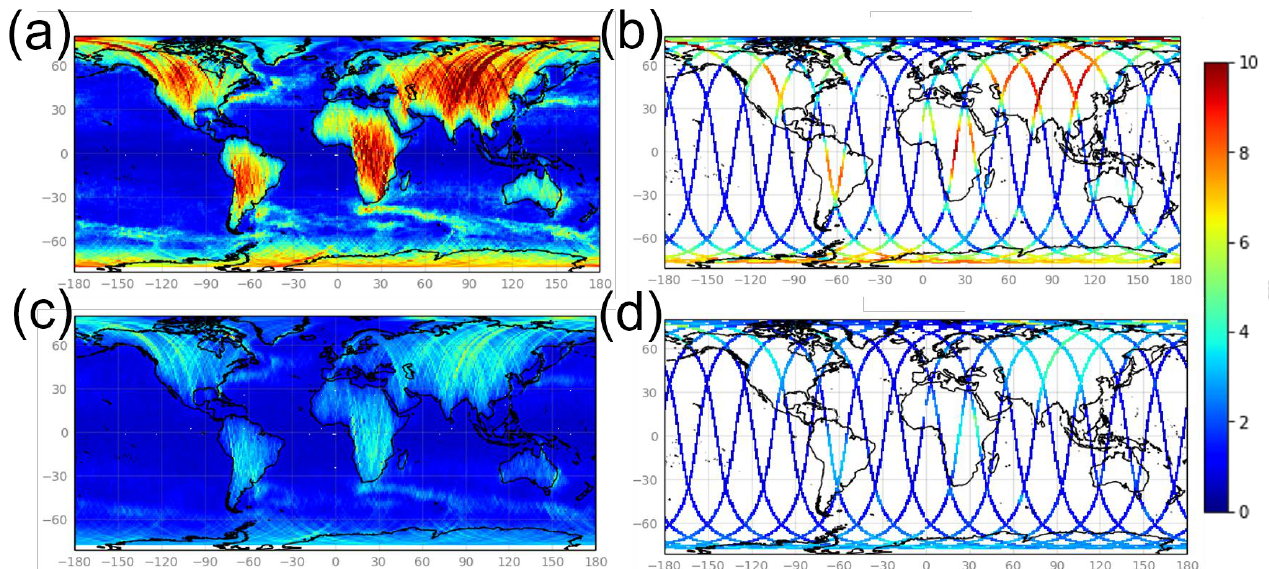
Figure 18. Residual systematic errors after the Level-3 data-driven calibration is applied (unit: cm RMS). The left panels are for SWOT’s 21-day orbit. The right panels are for the one-day orbit. The upper panels are for the “Spectral Allocation” uncalibrated scenario and the lower panels are for the “Current Best Estimate 2021” scenario. Table 3. Overview of the global Level-3 performance after data-driven calibration for different sce- narios. The left columns are for the global ocean (sea-ice regions are excluded) with the Root Mean Square Error (RMSE) in cm, the gain with respect to the Level-2 RMSE of Table 2 (in % of variance) and the wavelength λ where the calibration stops to be beneficial (measured from the power spectra of Figure 17). The right columns are for the inland regions with the RMSE in cm and the gain with respect to the Level-2 performance of Table 2 (expressed in % of variance).